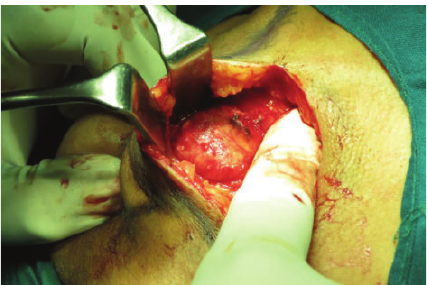
Figure 9: Extraoral approach revealed a well-defined mass adherent to the masseter.